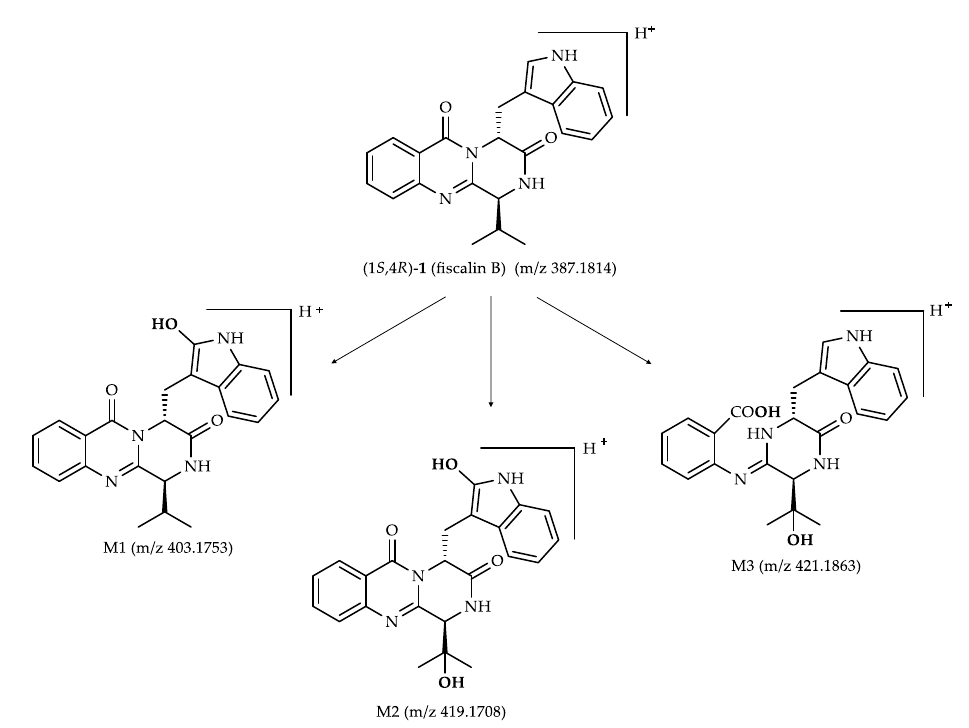
Figure 3. Inferred in vitro metabolites of 1 . Figure 3. Inferred In vitro metabolites of 1 .